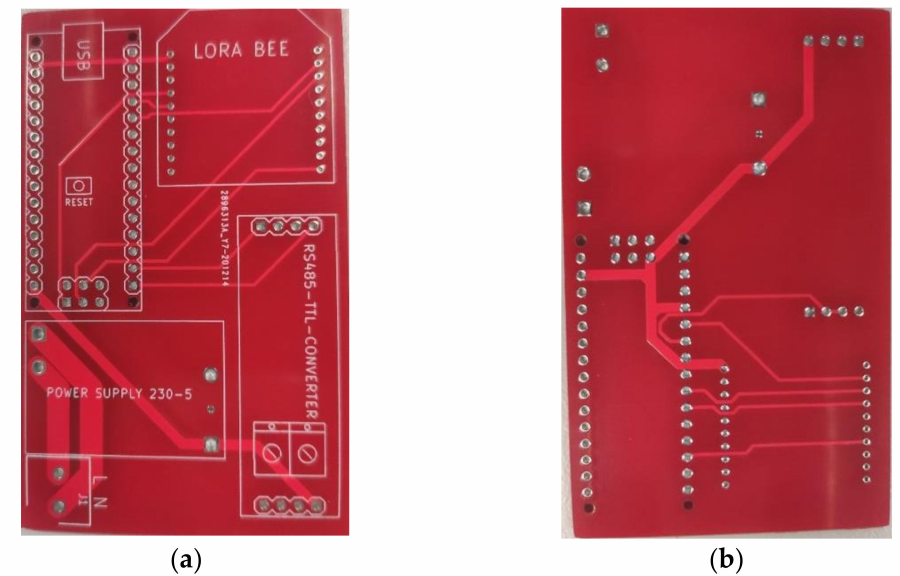
Figure 4. Printed circuit board (PCB): ( a ) front side; ( b ) back